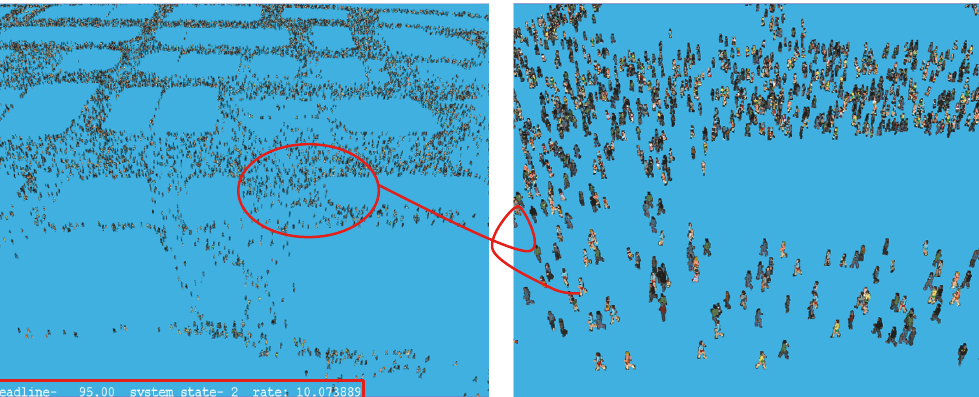
Figure 8: Rendering effect in State 2. The left picture shows that the group drawing vision is in State 2 and the drawing frame rate is 10.5fps; the right picture shows the partial magnification and we can see the model accuracy is slightly lower than the State 0, but the fineness of the model is not noticeable in the